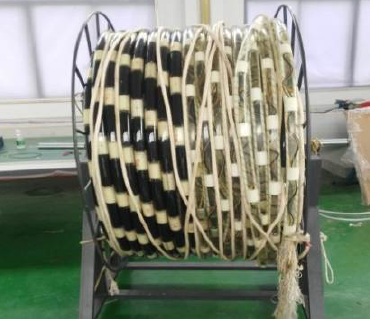
Fig. 10 FOH towed array.